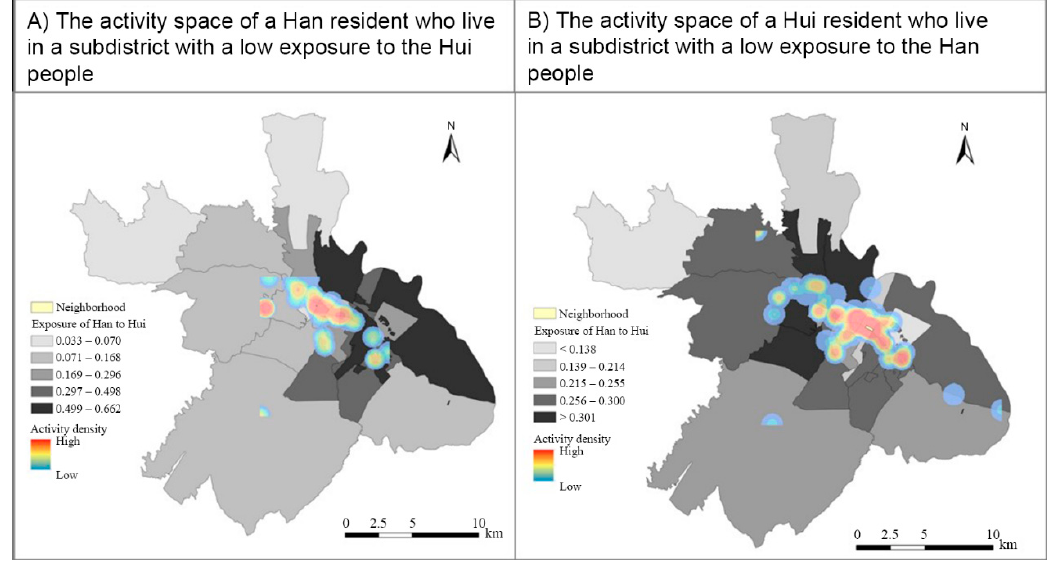
Figure 3. Examples of a Han resident and a Hui resident: ( a ) the activity space of a Han resident who lives in a subdistrict with low exposure to the Hui people; ( b ) the activity space of a Hui resident who lives in a subdistrict with low exposure to the Han people.